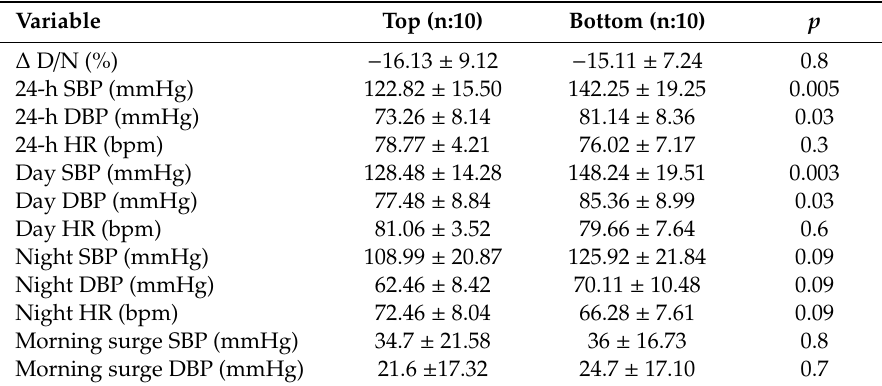
Table 5. ABPM data—asthmatics-top vs. bottom levels of FEV 1.